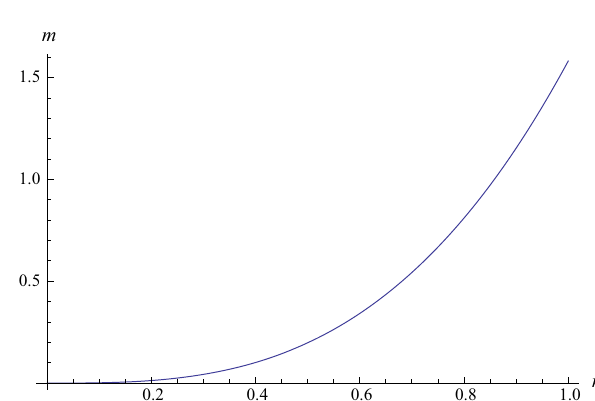
Fig. 2 Radial pressure P r with n = 1 ,α = 0 . 025 and d = 0 . 0804